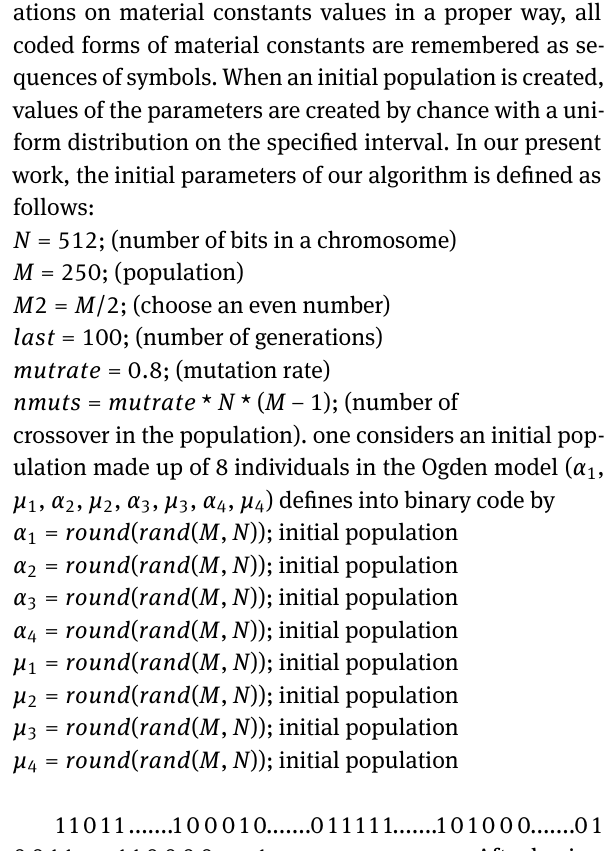
Figure 1: Flowchart